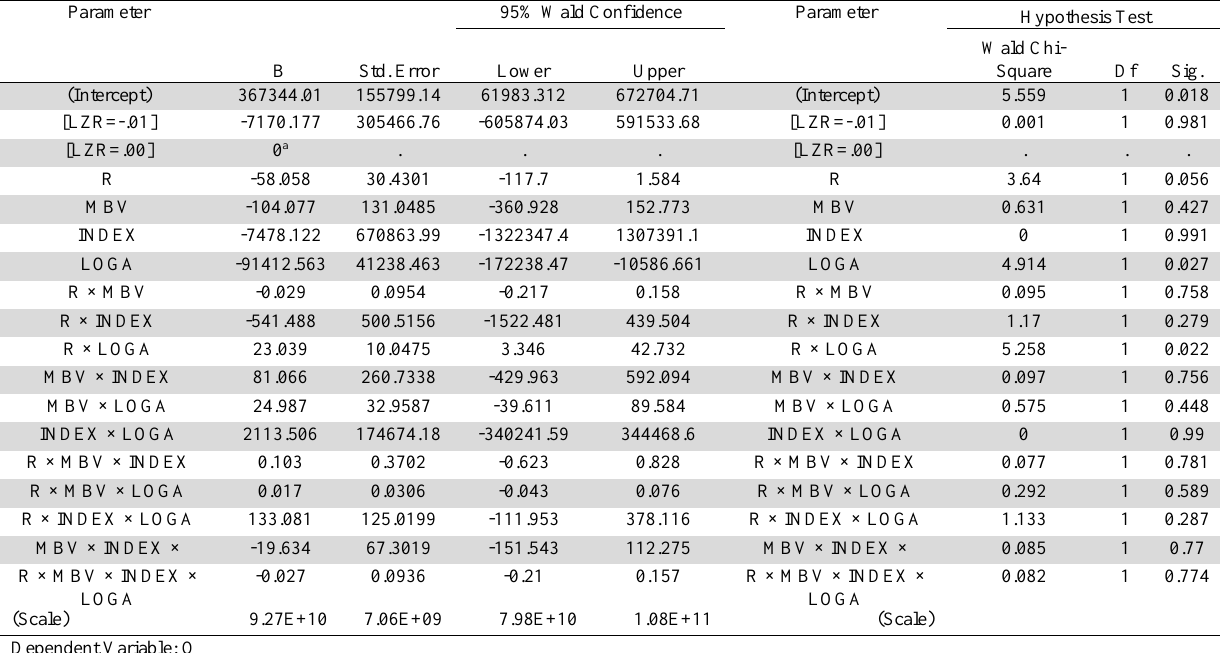
Table 9 The summary of parameter estimation